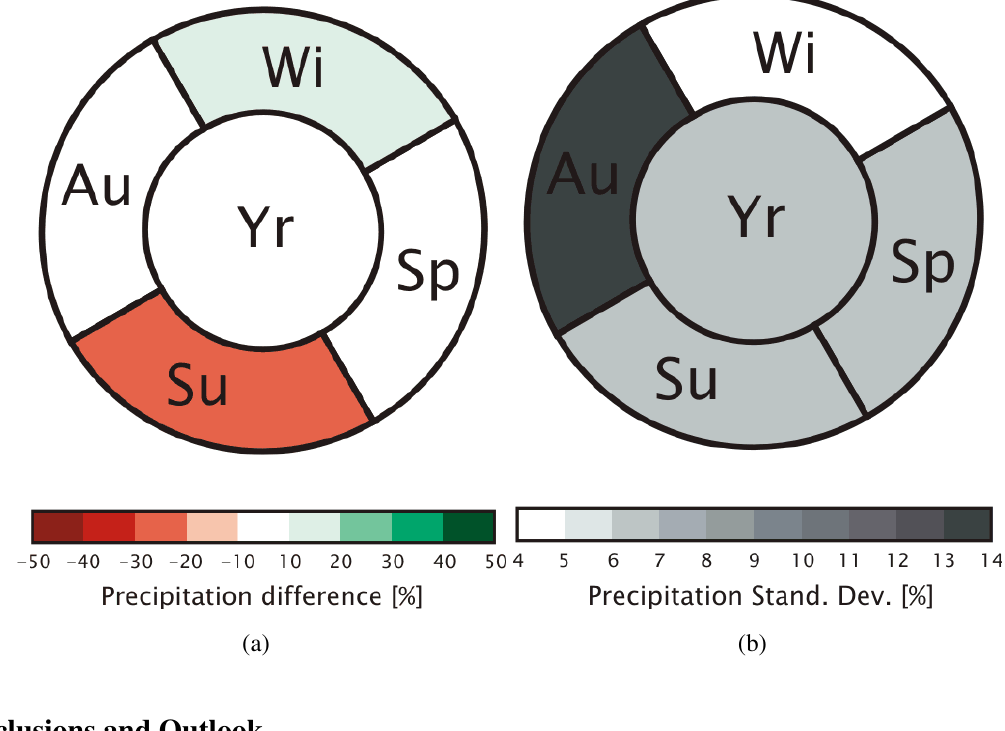
Figure 7. Ring diagram of ( a ) the mean and ( b ) the standard deviation of the precipitation signals of the ensemble members that involve two- or three-tier model cascades. Time frame: Difference 2071–2100 (A1B) and 1971–2000 (20C). The central circle denotes the annual values and the ring segments around it are color coded according to the seasonal values for spring (Sp), summer (Su), autumn (Au) and winter